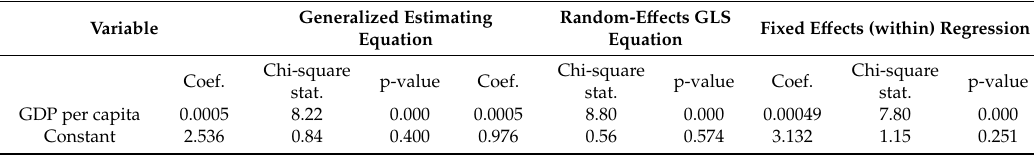
Table 1. Panel data models to explain the share of renewable energy in final consumption in the EU-28 countries (2007–2017).